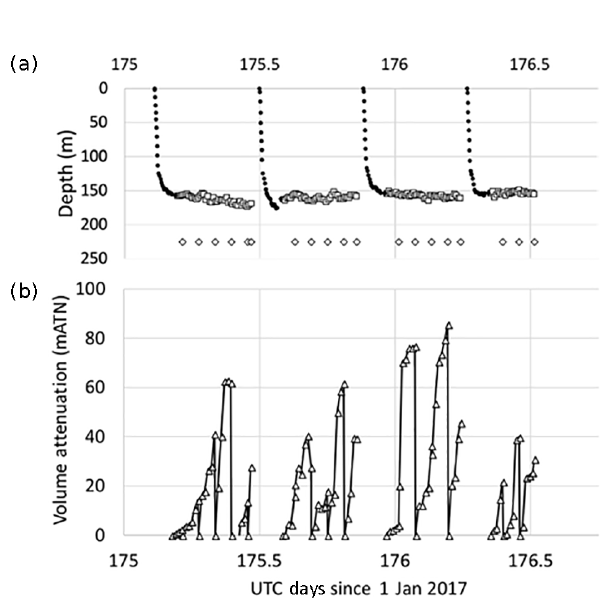
Figure Appendix A1. (a) Typical deployment trajectory of a CFE- Cal. This particular deployment is from CFE2, the first deploy- ment at location 4. The x axis is time in days (1 January 2017 at 12:00UTC = day 0.5). The filled black circles are depths as the CFE-Cal is diving, open black squares denote depths as the CFE drifts and takes images of settled particles. The open black dia- monds represent times when the sample stage was cleaned and par- ticles were directed into a sample bottle. (b) The corresponding at- tenuation for each photo taken. Particles build up over time and then periodically the glass stage will be rinsed off and particles directed into the sample bottles. Due to a programming error, the sampler and particles are not removed from the stage.